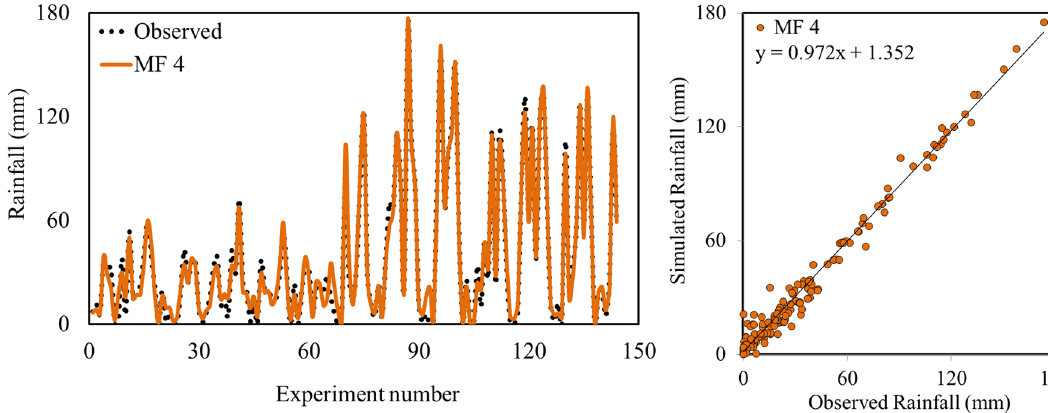
Fig. 10 Comparison between precipitation values simulated by optimal MFs equal to four and observed precipitation values in